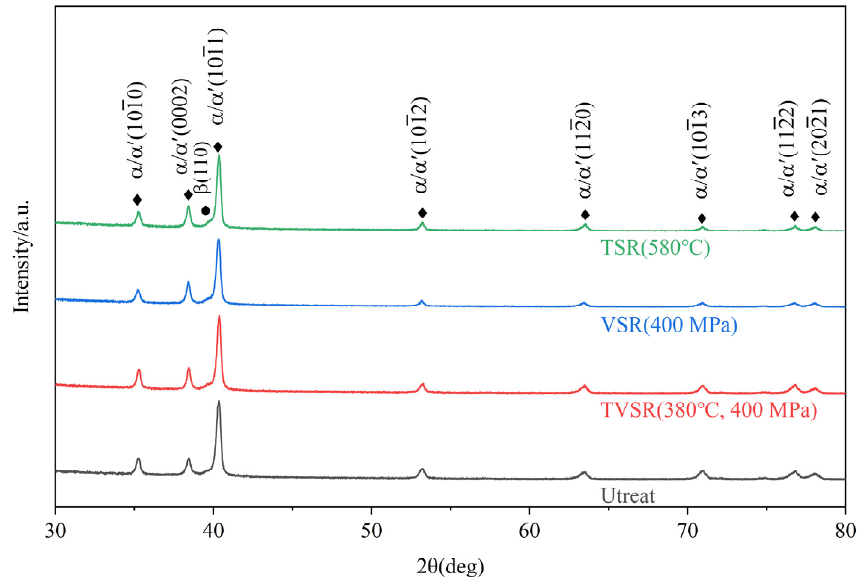
Figure 6. XRD patterns of SLMed Ti6Al4V samples before and after stress relief treatments.